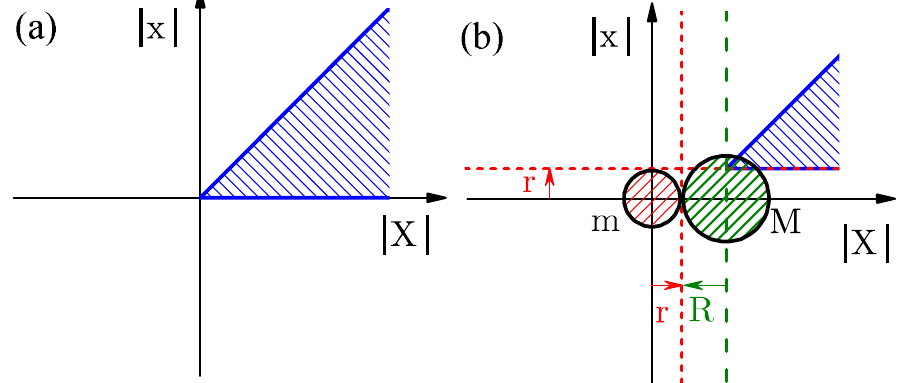
Figure 12. Configuration space for ( a ) two point balls ( b ) balls of size r and R . Mapping (54) translates configuration space ( b ) into ( a